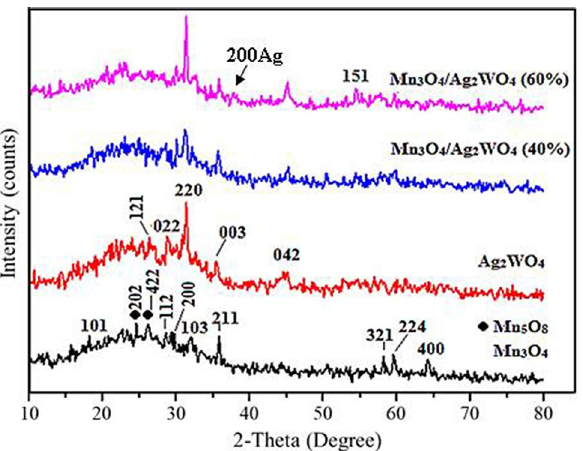
Figure 1. XRD patterns of Mn 3 O 4 , α-Ag 2 WO 4 , Mn 3 O 4 /α-Ag 2 WO 4 (40%) and Mn 3 O 4 /α-Ag 2 WO 4